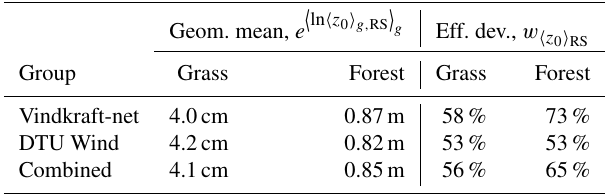
Table 2. Bootstrapped statistics of mean roughnesses from (resam- pled) user-provided z 0 given by two groups of wind resource ex- perts, using three resampled values per mean calculation; data are for the two terrain types shown in Fig.